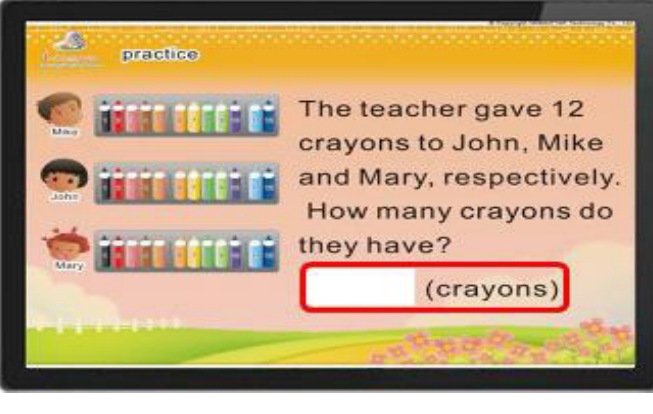
Figure 5 . SimMAGIC e-book interactive